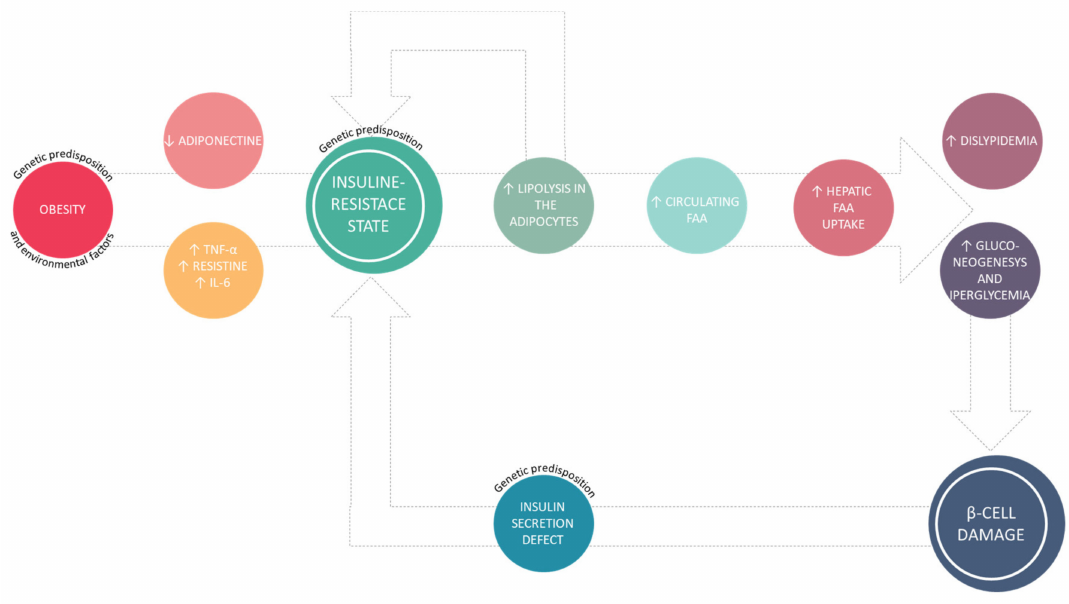
Figure 1. Pathophysiology of type 2 diabetes mellitus